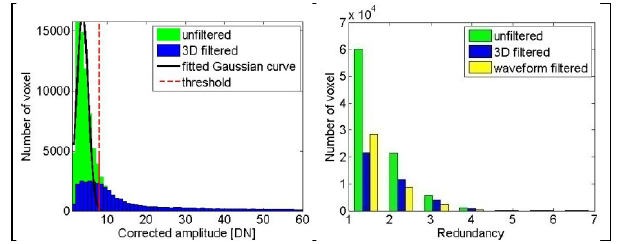
Figure 12. Histograms of voxel attributes (left) and voxel entries (right) of unfiltered and filtered voxel space